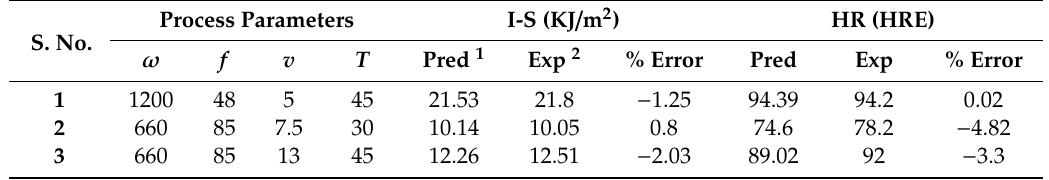
Table 6. Comparison between the experimental and predicted responses values. S. No.